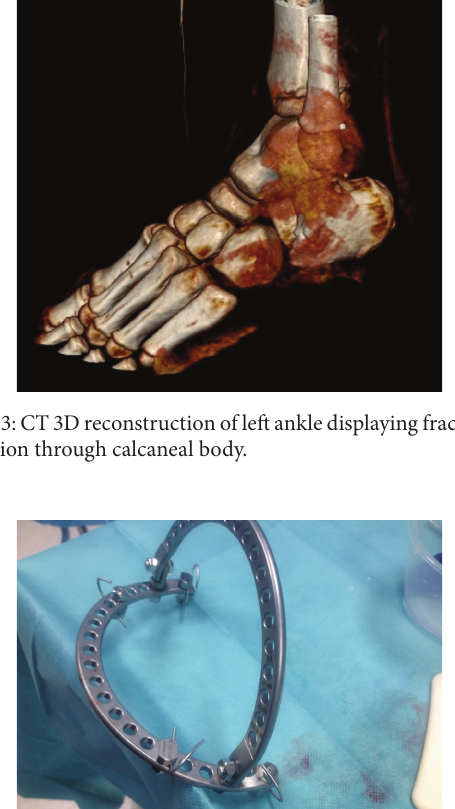
Figure 1: (a) Anteroposterior radiograph displaying two-part extra- articular calcaneal fracture. (b) Lateral radiograph displaying two- part extra-articular calcaneal fracture.